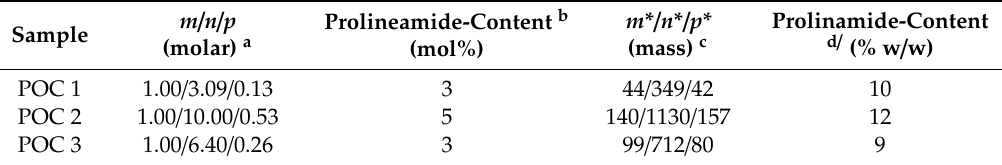
Table 3. Copolymer composition and catalyst loading of the amphiphilic block copolymers bearing the immobilized